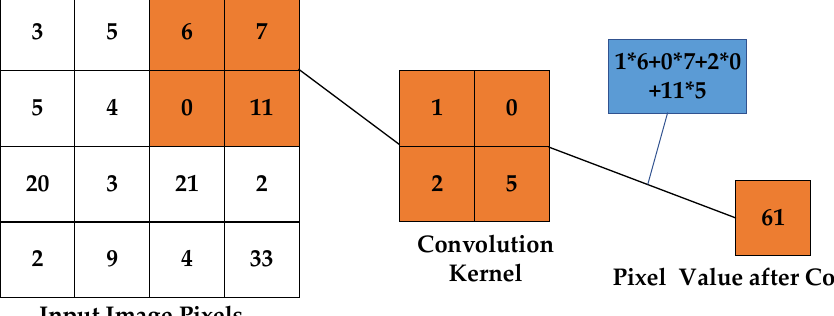
Figure 7. Convolutional operation diagram.